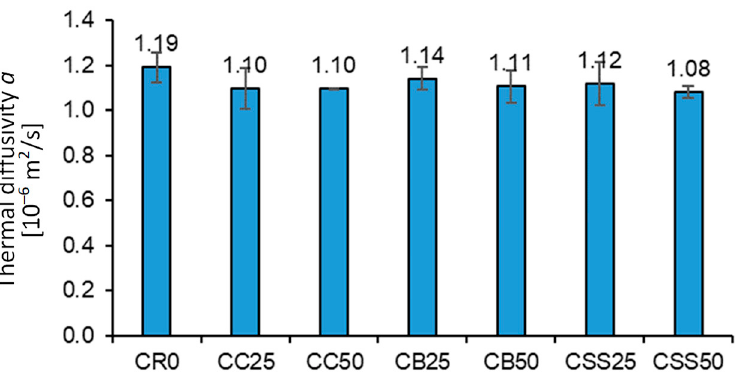
Figure 15. The average values of concrete thermal diffusivity.